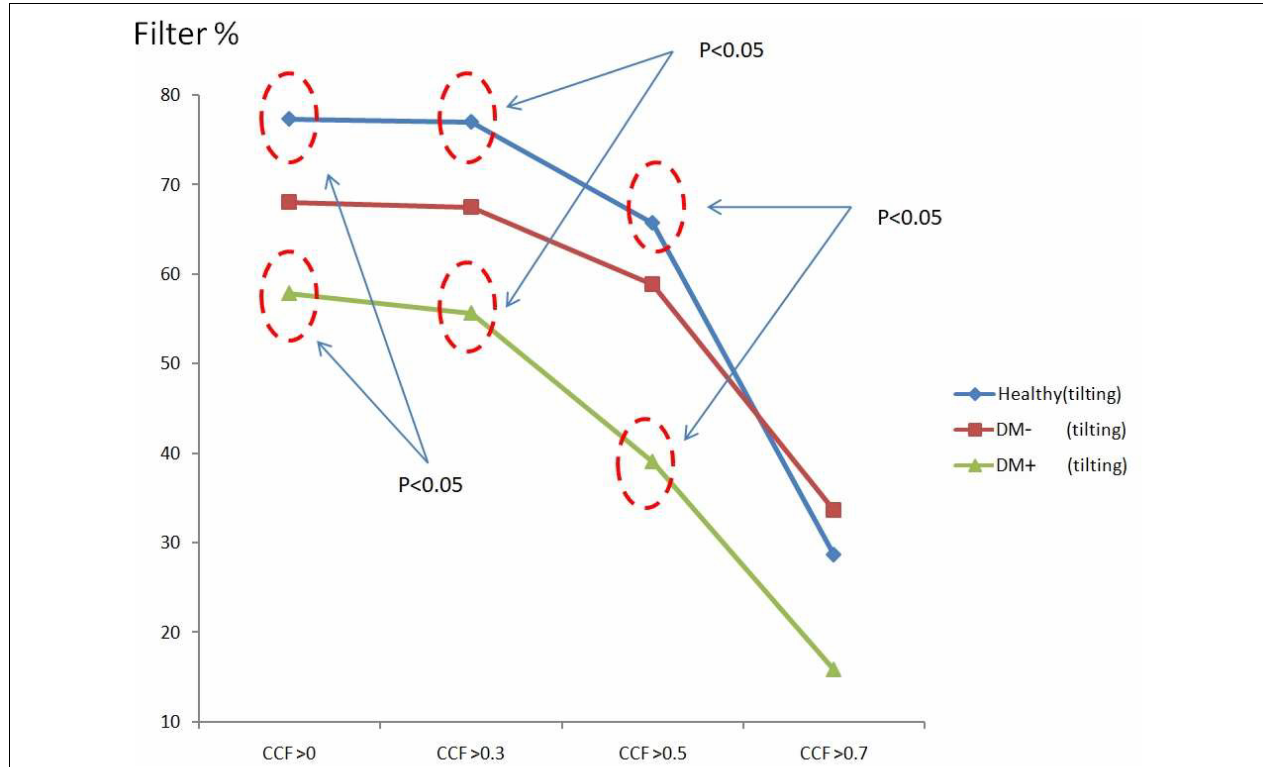
FIGURE 8 | The plot of filter % with different thresholds by ACCF results in a tilting position. ACCF results of tilt. Filtered maximum CCF value (% to all CCF values) using the threshold CCF > 0, 0.3, 0.5, and 0.7 in resting position in healthy (blue), diabetes mellitus (DM–, red), and DM with autonomic neuropathy (DM+, green). CCF thresholds of > 0, > 0.3, and > 0.5 allowed for the differentiation of healthy and DM+